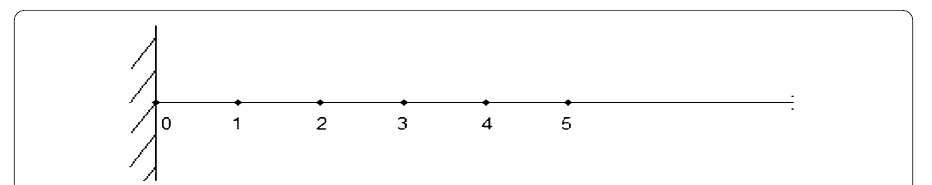
Figure 3 Grid point discretization for left